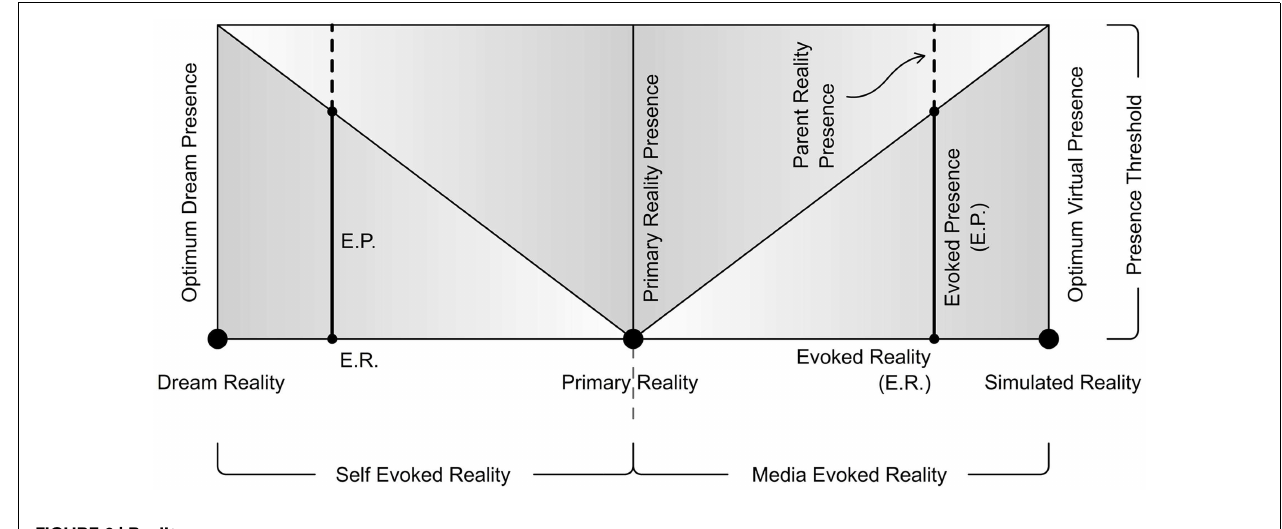
FIGURE 6 | Reality-presence